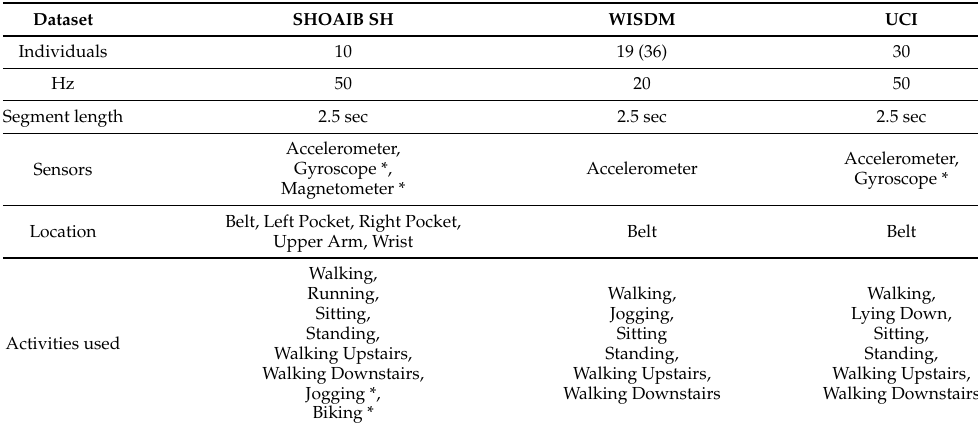
Table 2. Summarization of SHOAIB (SH) [2], WISDM [25] and UCI [26] datasets. Items marked with (*) were not used in the experiment.